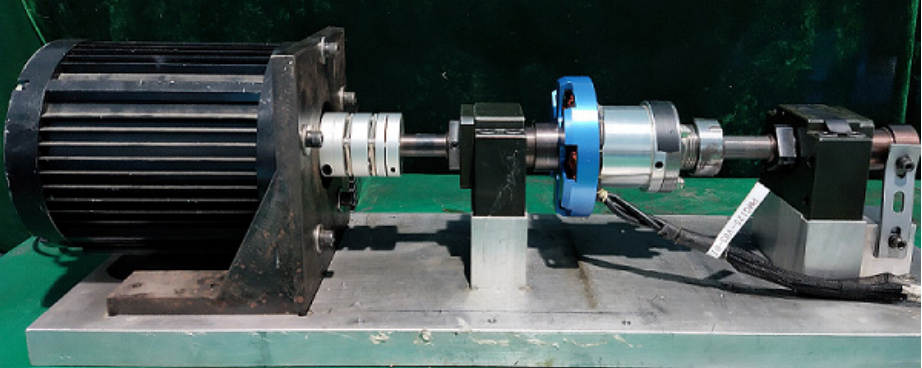
Figure 2. Schematic diagram of input and output of power generation unit model.